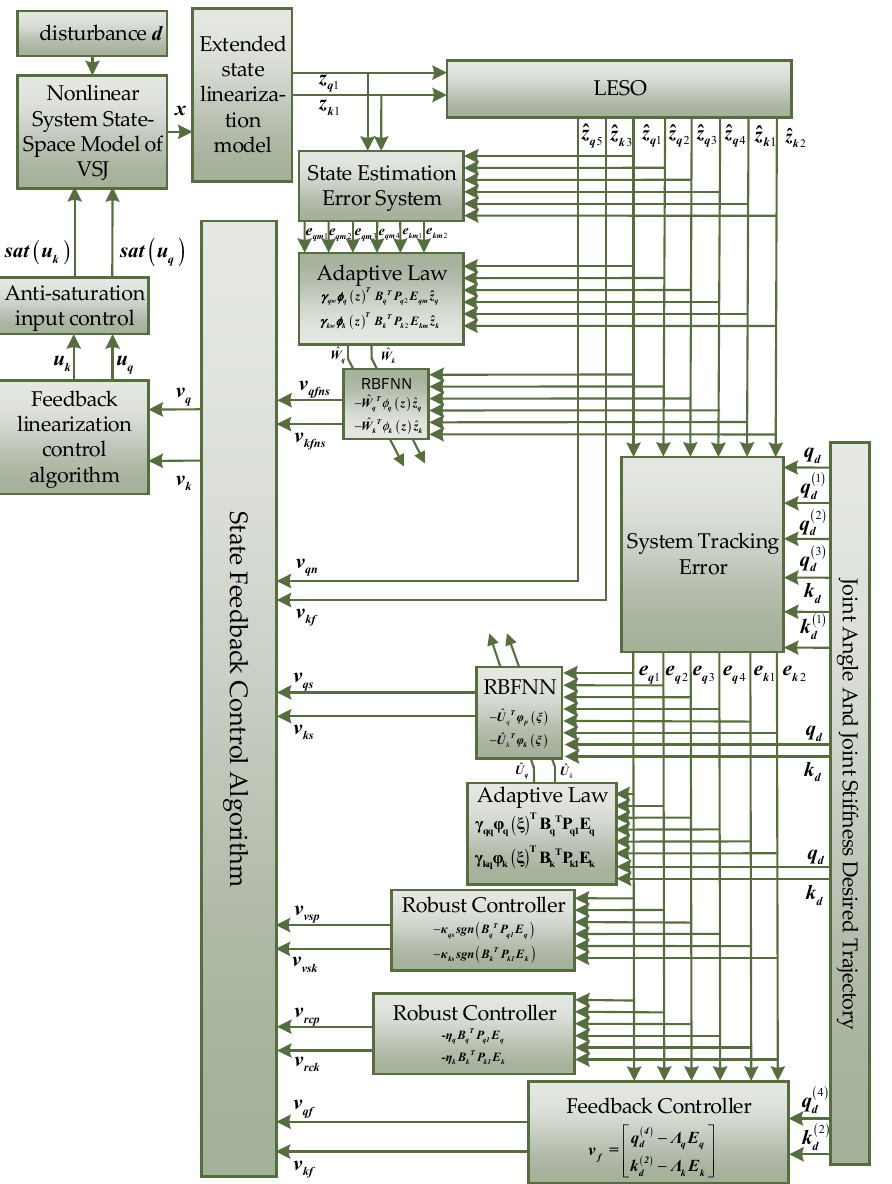
Figure 3. The scheme diagram of the FL+LESO+RBFNN+ISC controller. FL: feedback linearization; LESO: linear extended state observer; RBFNN: Radical Basis Function Neural Network; ISC: input saturation compensation.